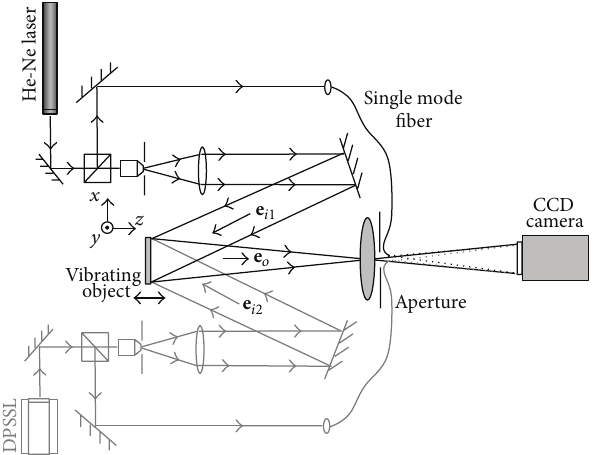
Figure 7: Schematic layout of dual-wavelength image-plane digital holography for dynamic measurement (reprint from